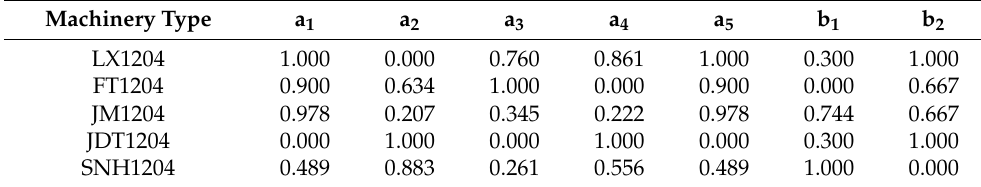
Table 3. Relevant data of 88.2 kW power machinery of 68 regiment (after standardization).